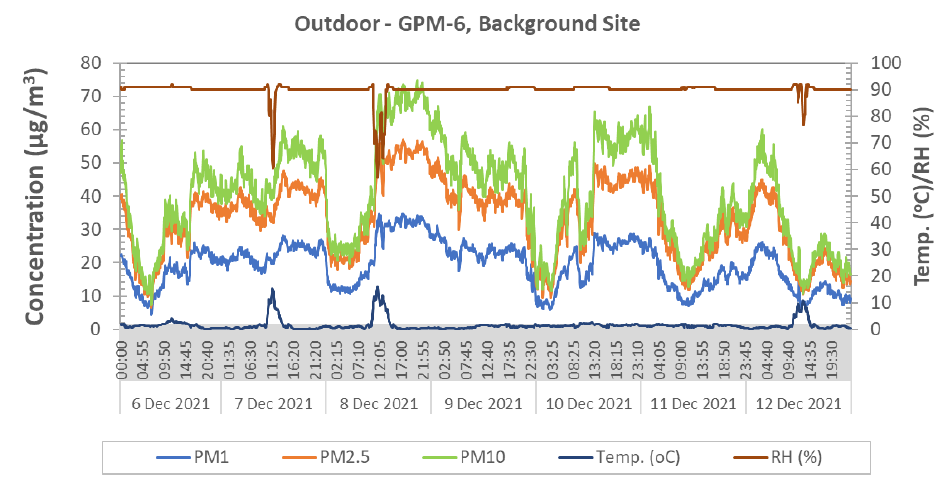
Figure 15. Temporal PM and microclimatic data for the GPM sensor at the background site (outdoor) recorded between 6 and 12 December 2021 (sampling rate: 5 min, n = 2002).